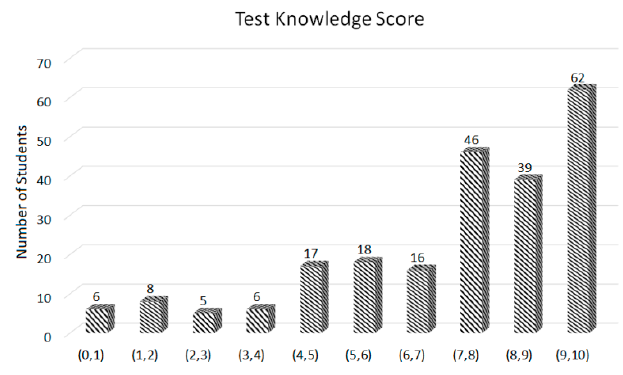
Figure 7. Test Knowledge Score.